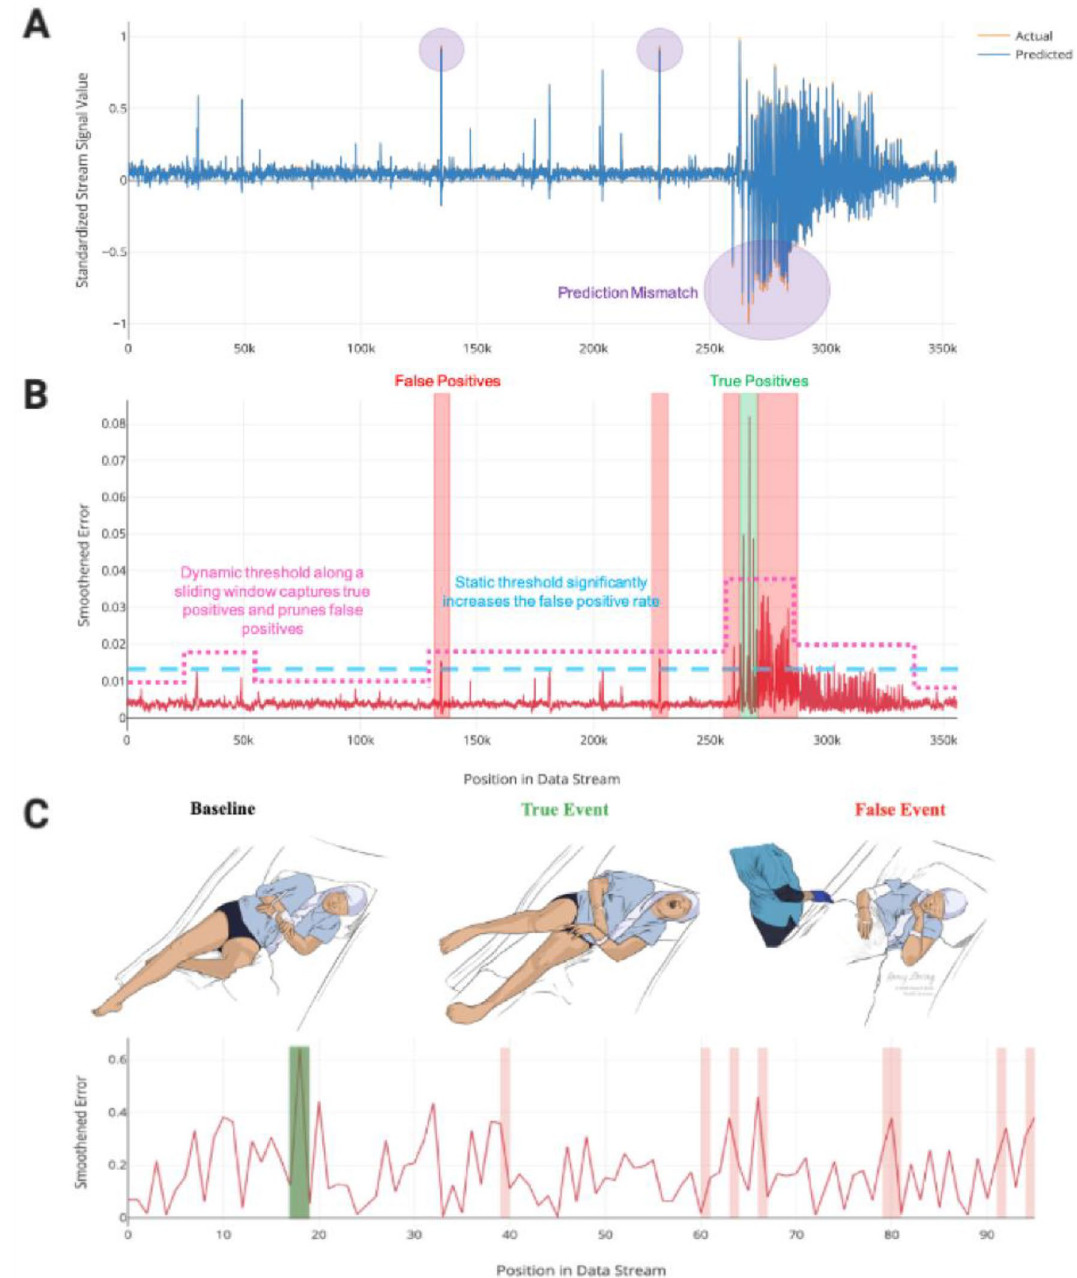
Figure 4. Self-supervised error thresholding for real-time detection of anomalies in SEEG and video data. An LSTM network is trained to predict the next window of values in the test time series sequence ( A , blue). These values are compared to the actual values ( A , orange), and a smoothed error is calculated for each value in the sequence ( B , red sequence). Prediction mismatches ( A , purple) manifest as higher errors. A self-supervised dynamic threshold ( B , magenta line) enables effective local classification of true anomalous sequences ( B , green bar) while omitting many of the false positives ( B , red bars) that result from traditional static thresholding methods ( B , blue line). Concurrently acquired video recordings for each patient were considerably noisier and signal reconstruction was not as robust, demonstrated by the higher reconstruction errors ( C , red sequence). While video sequences captured all of the true seizure events in the study population ( C , middle, green bar), they also captured several false positive events, such as nurse visits ( C , far right, red